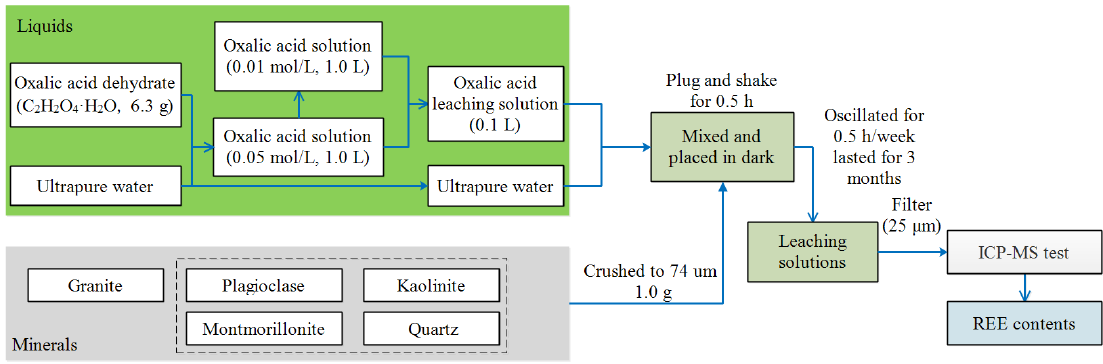
Figure 1. Oxalic acid leaching experiment for the